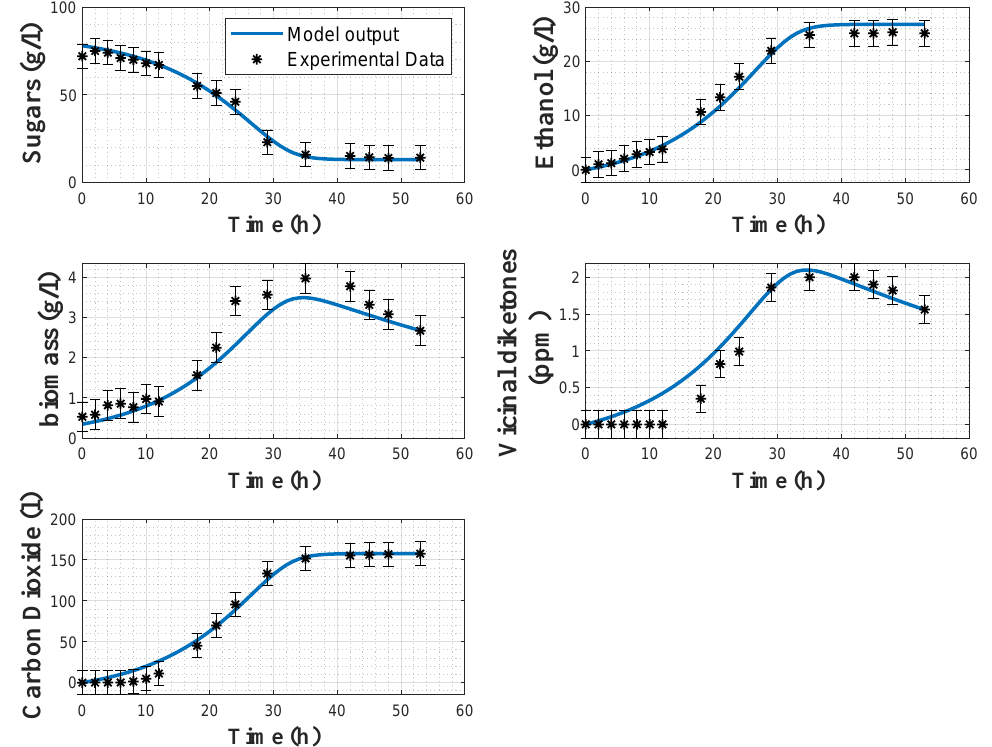
Figure 2. Direct validation of the biomass model with the data from experiment 2. Stars: experimental data. Error bars: 95% confidence intervals. Continuous blue line: model